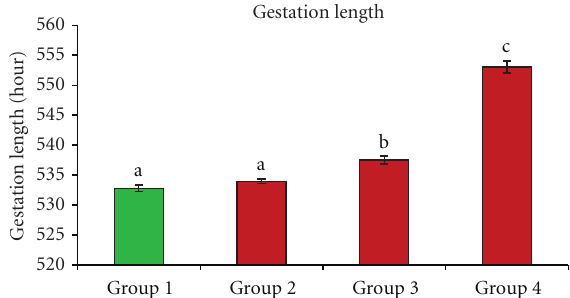
Figure 2: The gestation lengths of the control group (group 1) and groups exposed to elevated ambient temperature. The bars represent the mean ± SEM. Data labeled with di ff erent letters are significantly di ff erent at P < 0 . 001.